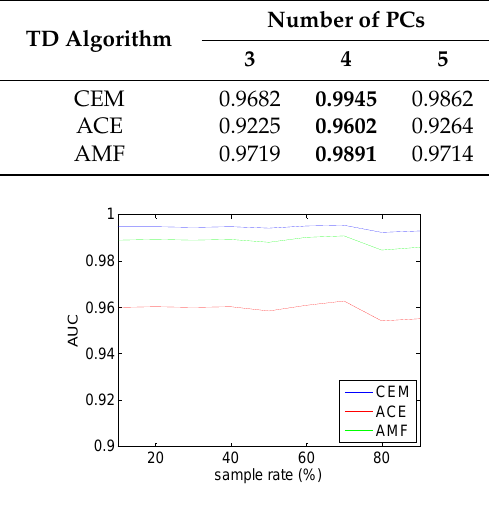
Figure 4. AUCs with different sample rates.